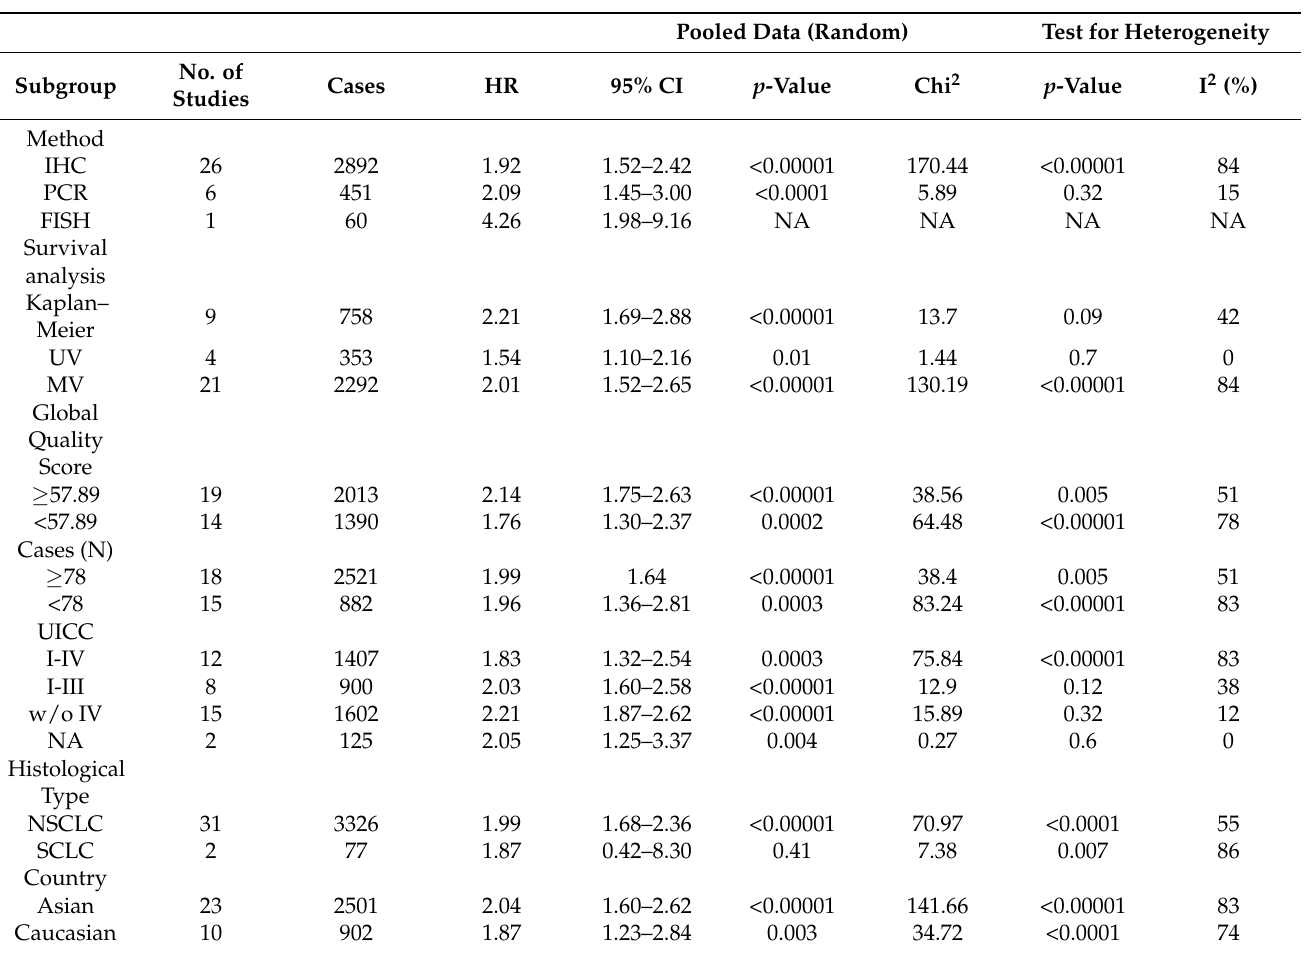
Table 3. Subgroup analysis of summarized hazard ratios reflecting the relationship between survivin/BIRC5 and overall survival in lung